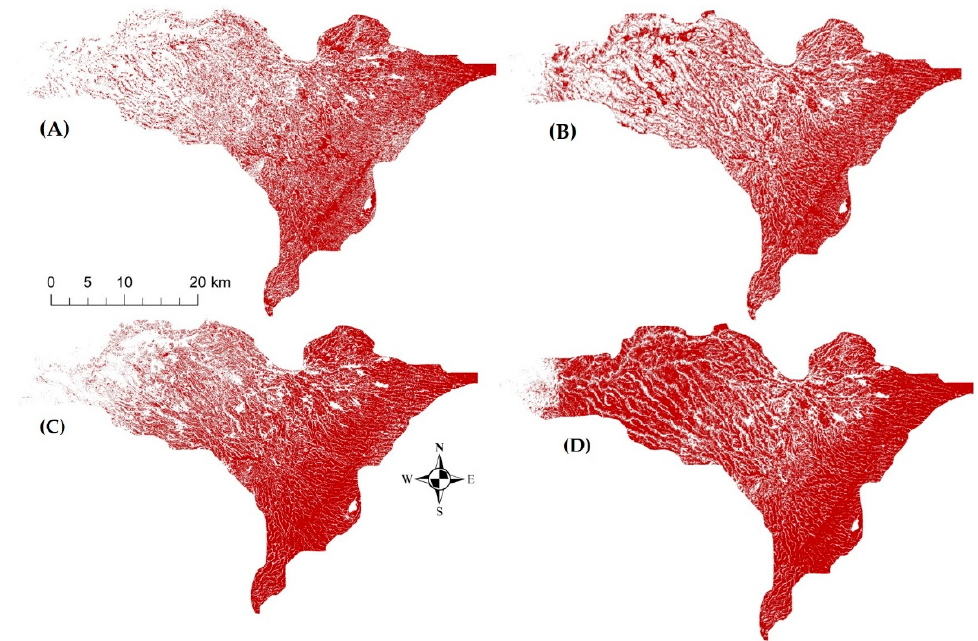
Figure 4. Agricultural expansion in the watershed in ( A ) 1988—44954.50 ha, ( B ) 1998—51892.20 ha, ( C ) 2008—58441.50 ha, and ( D ) 2018—59792.90 ha.